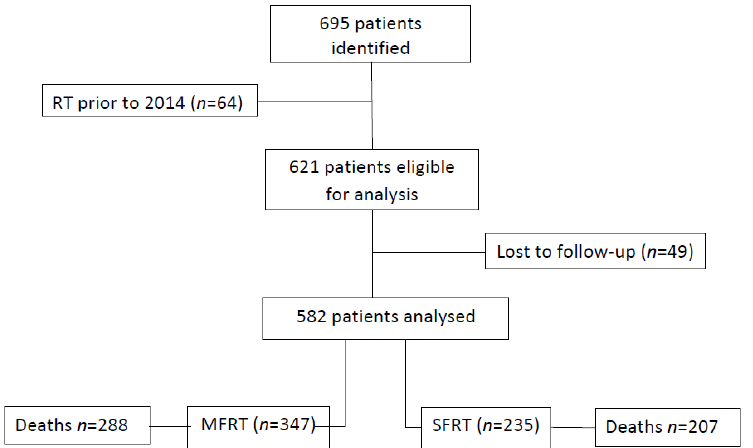
Figure 1. Study design. RT: Radiotherapy, MFRT: multiple-fraction radiotherapy, SFRT: single-fraction radiotherapy.